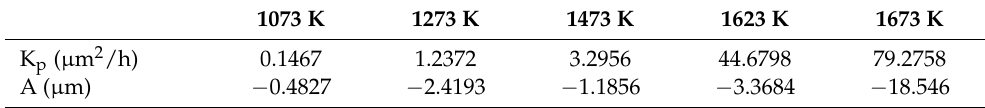
Figure 4. ZrC layer thickness versus the square root of time during the isothermal holds from solid state carburization (1073, 1273, 1473, 1673 K) and pack carburization (1623 K).